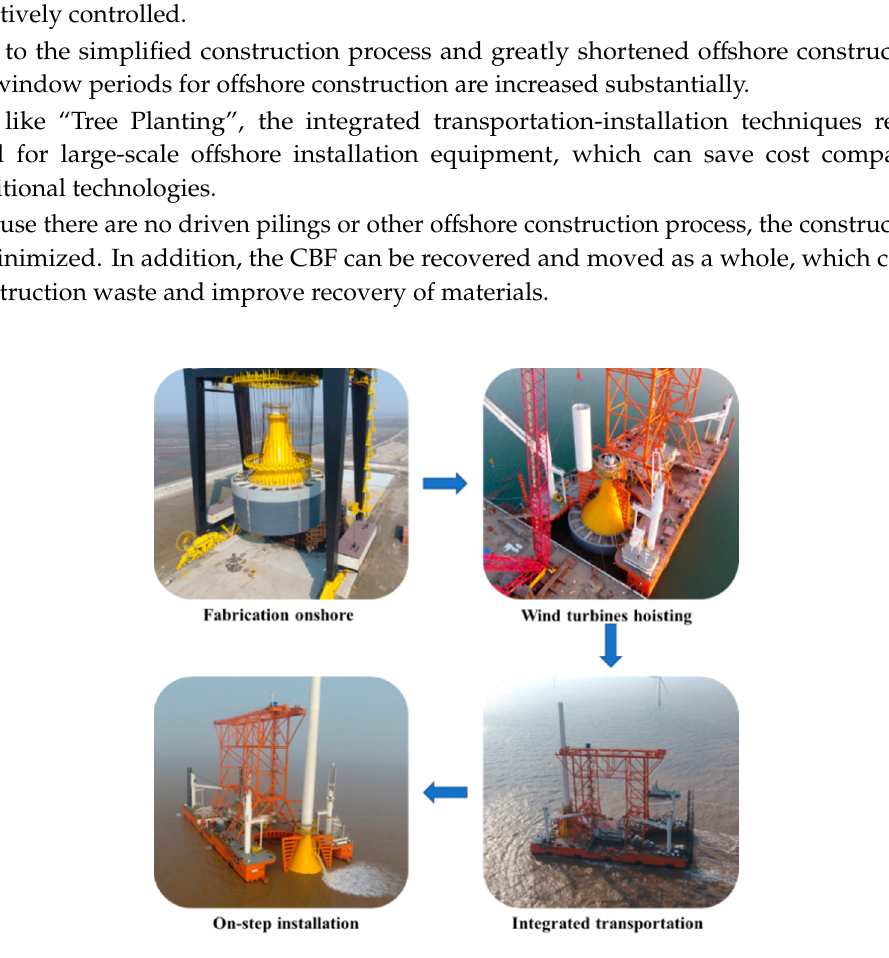
( a ) The lashing process.